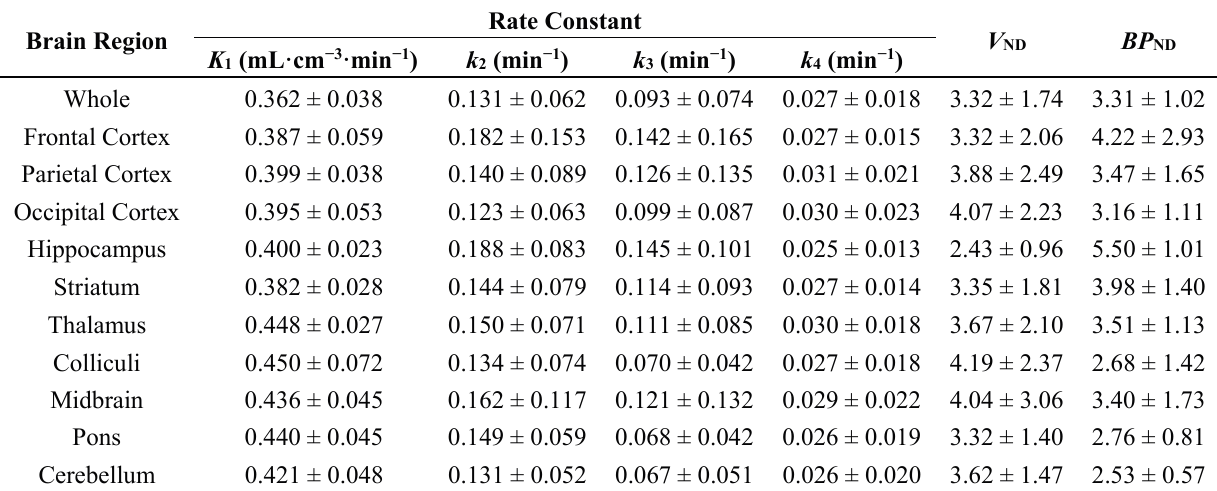
Table 3. Kinetic rate constants, non-displaceable volume of distribution ( V ND ), and non-displaceable binding potential ( BP ND ) of [ 18 F] 10a in different regions of piglet brain using 240 min of scan data under baseline conditions ( n = 3).